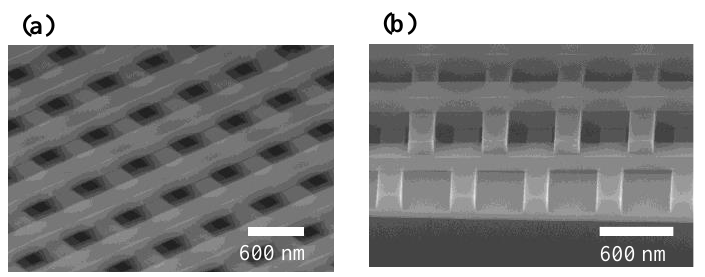
Figure 12. Scanning electron microscope (SEM) images of stacked structures observed from tilted angles ( a , b ).